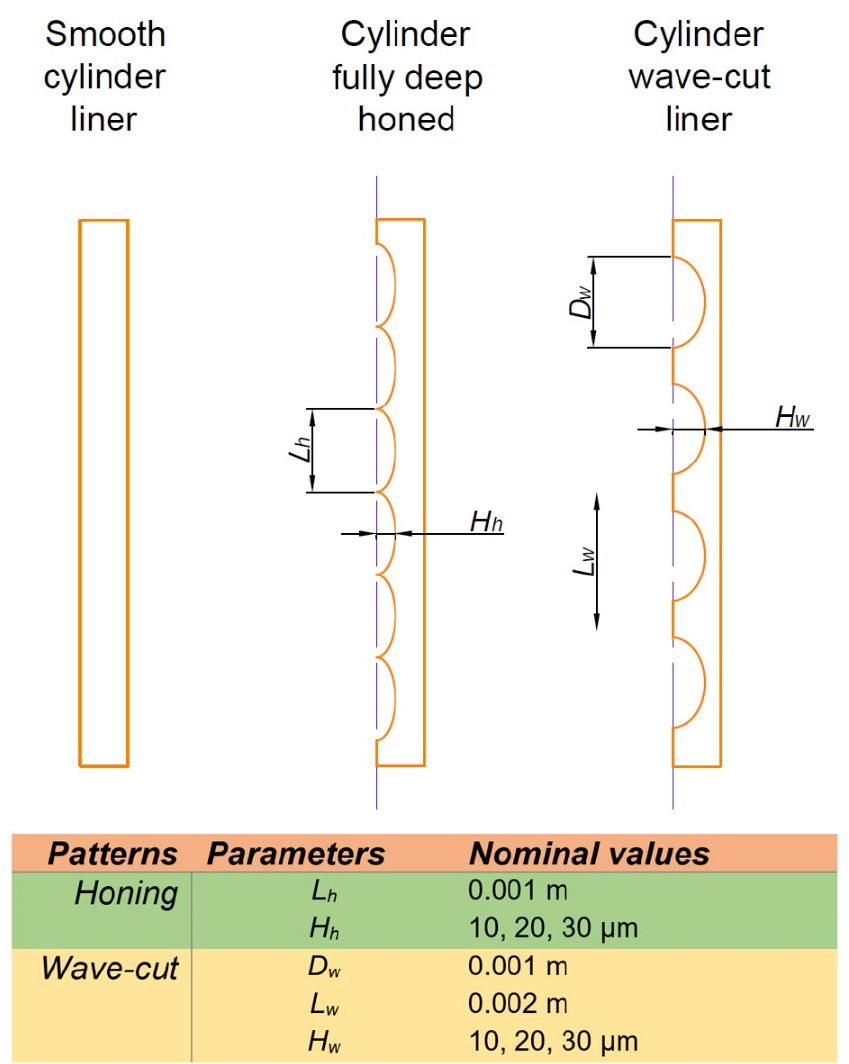
Figure 28. Scheme of the surface of the cylinder, after [142].